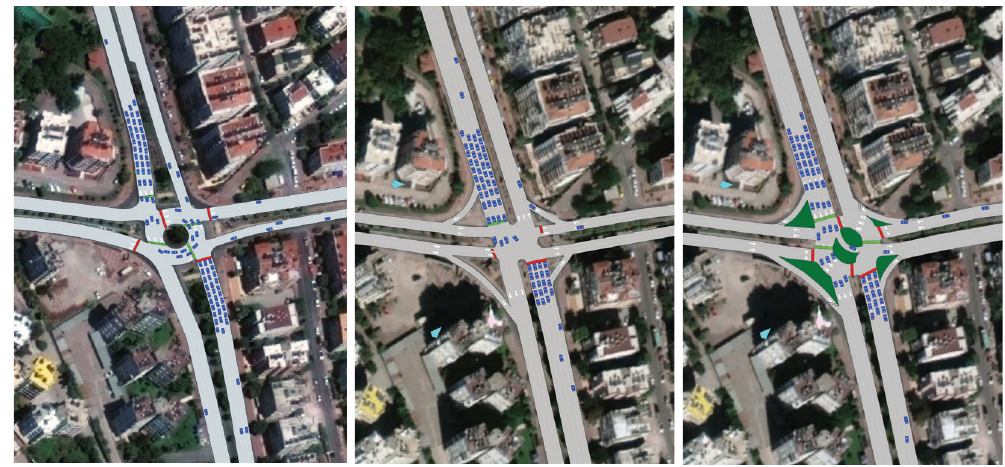
Figure 16. Simulation images for the roundabout status in 2016, in the current status and the status as per the proposed roundabout (by